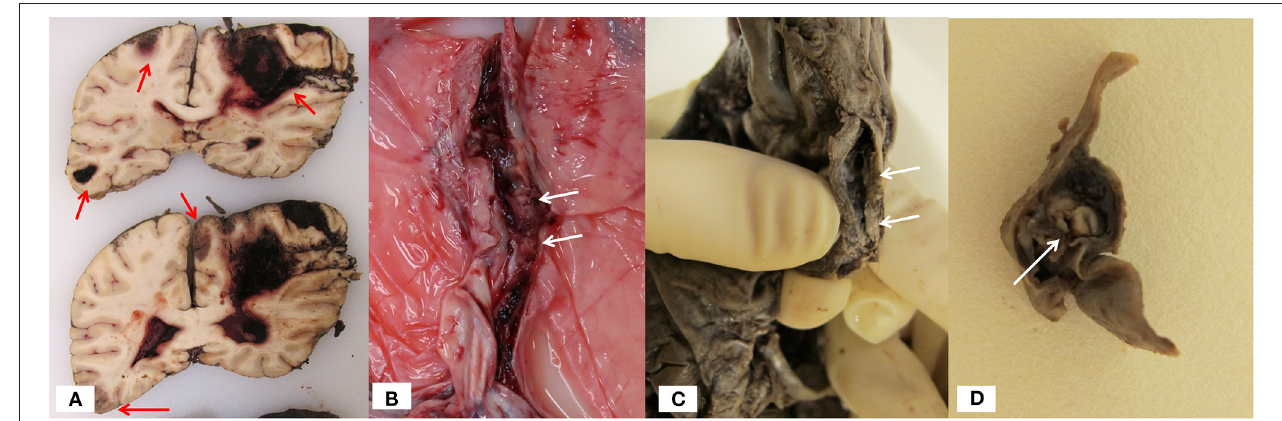
FIGURE 4 | Autopsy findings in patient 5: (A) Coronal section of the formalin-fixed brain. Extensive hemorrhagic infarction (red arrows) in both hemispheres and major hemorrhage with communication to the brain surface and ventricular system. (B) Posterior sagittal sinus with a white thrombus. (C) Formalin fixed dura. Sagittal sinus with thrombus formation (arrow). (D) Cross-section of formalin fixed right transverse sinus with white thrombus